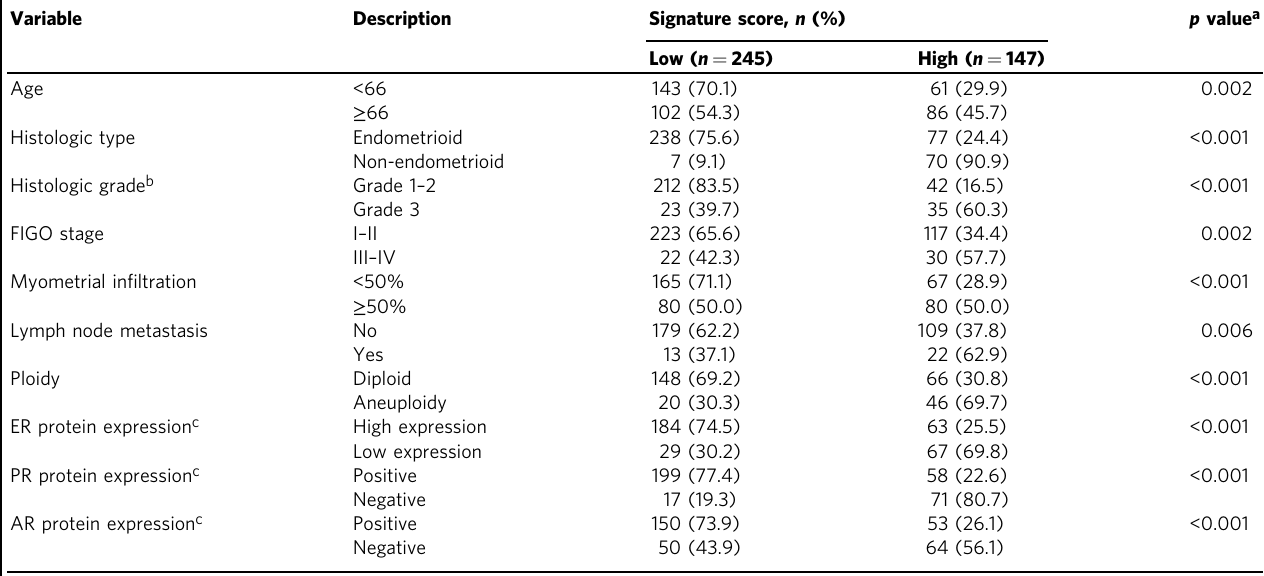
Table 3 Clinico-pathological variables in relation to the 11-gene signature score in the L1000 dataset ( n = 392).